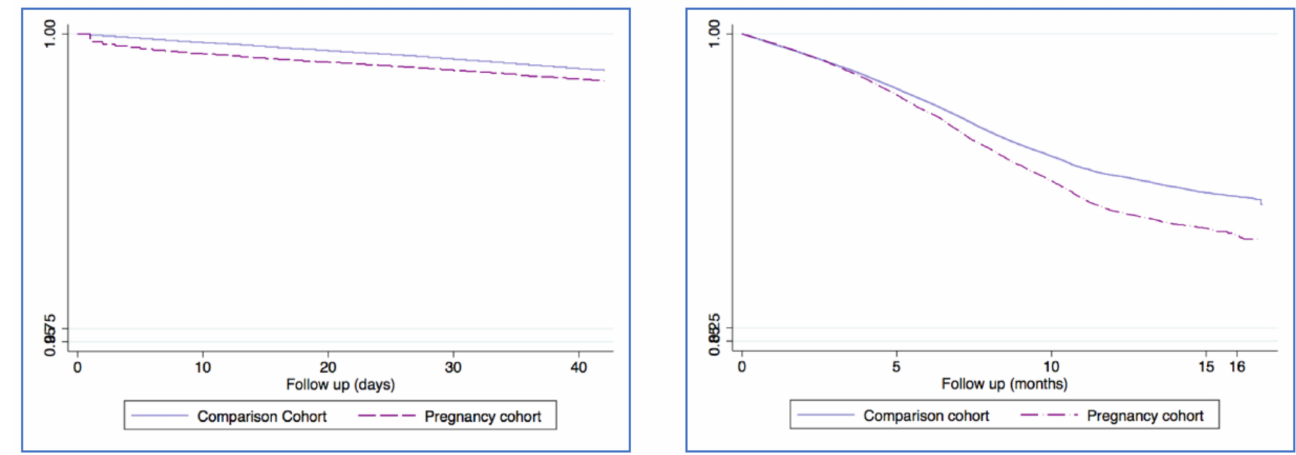
Figure 3. Kaplan Meier Cumulative incidence of SARS-CoV-2 infection according to puerperium period (figure in the left side) and post puerpuerium (figure in the right